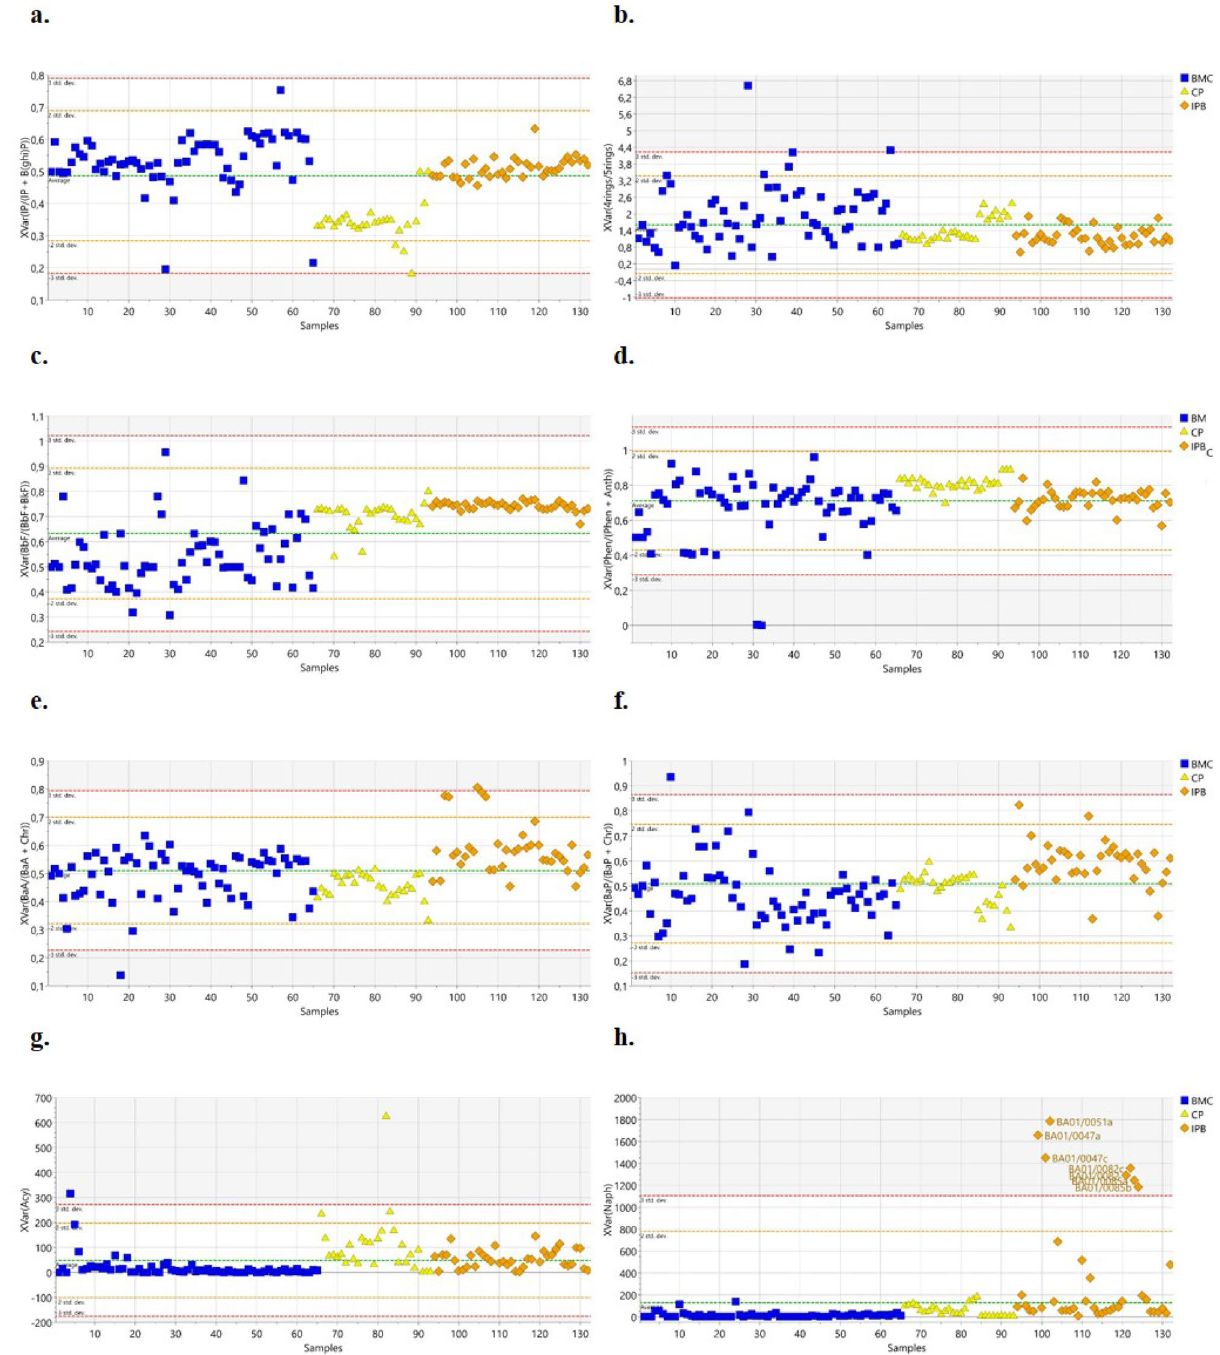
Figure 5. Statistic trend of the most significant variables (not scaled values) in BMC (Mar Piccolo Basin), IPB (International relevance port) and CP (Commercial Port) classes: ( a ) IP/(IP + BghiP), ( b ) 4-rings/5-rings, ( c ) BbF/(BbF + BkF), ( d ) Phen/(Phen + Anth), ( e ) BaA/(BaA + Chr), ( f ) BaP/(BaP + Chr), ( g ) Acenaphthylene (Acy), and ( h ) Naphtalene High concentration of Naph found in Port of Bari samples (IPB) and, to a less extent, in CP ports (Fig. 5h), with abnormal values logged in quays subjected to heavy passenger ships traffic (samples flagged with names in Fig. 5h), supported the hypothesis of pyrolytic PAH fingerprint related to traffic ships emissions 60 . Finally, the predominance of 3-ringed PAHs in the sediments of CP (and in BMC as well) (Fig. S7d) suggested an effect of heavy traffic by both land and sea in these areas 64 .